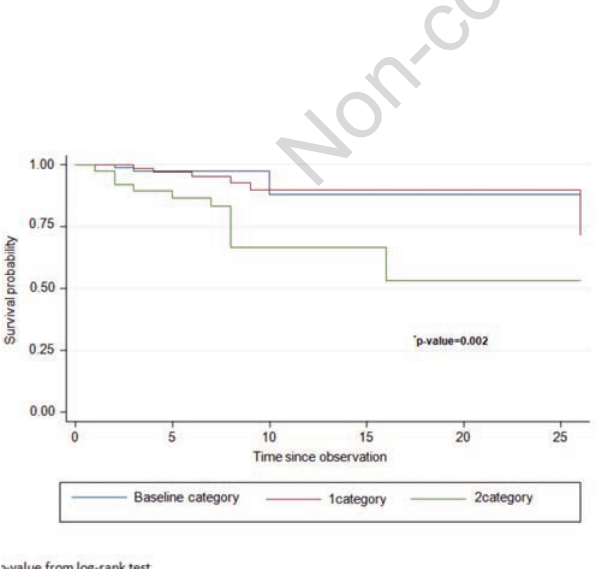
Figure 8. Kaplan-Meier curves for cardiac disease mortality in the three categorized Thalassemia Major groups. The 2 category was represented from patients with a LVEF >7% during the